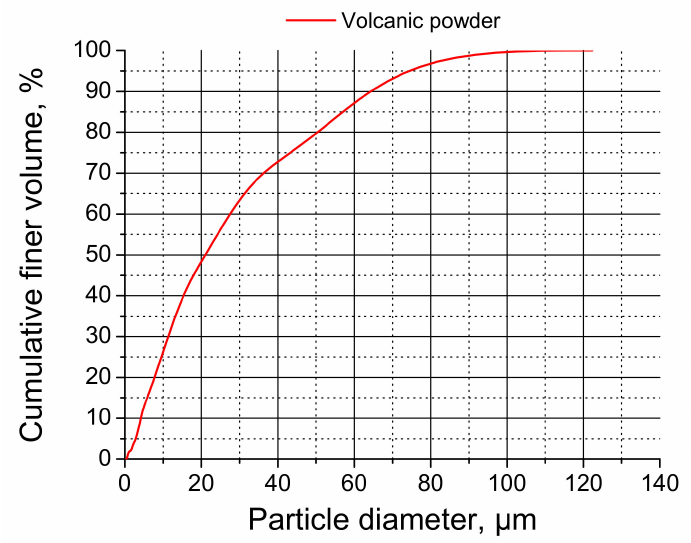
Figure 1. Size distribution of particles of studied